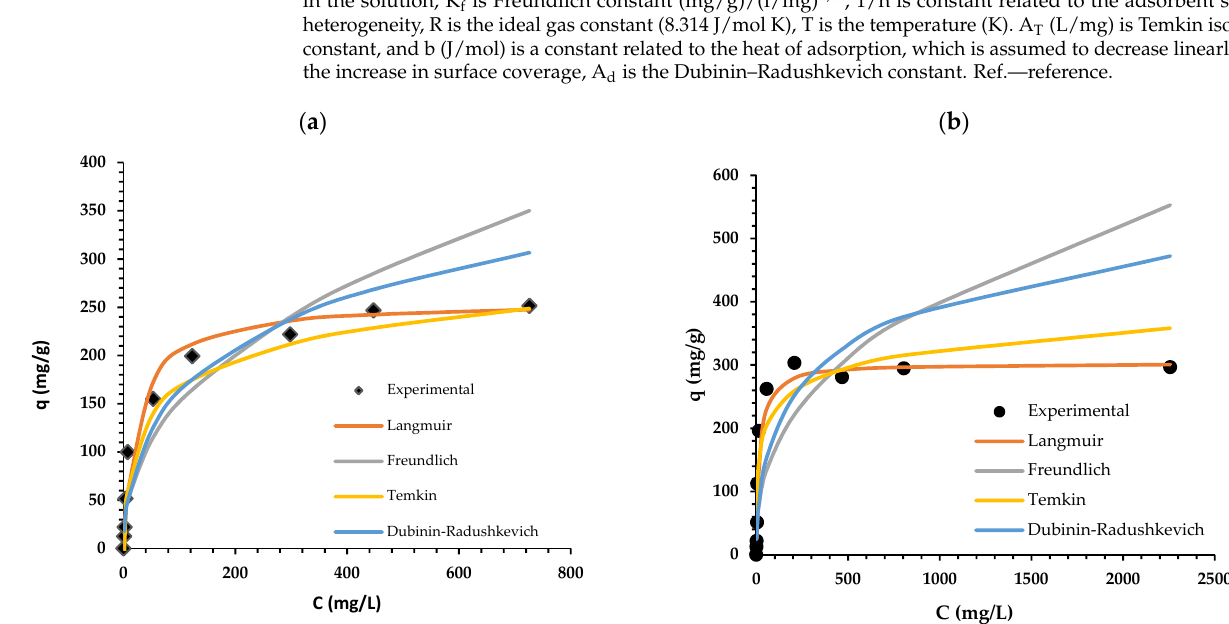
Figure 8. The efficiency of eucalypt stump lignin and kraft lignin in the removal of Cr(VI) at different initial concentrations. The FTIR spectra of the lignins before and after the adsorption experiments show noticeable differences (Figure 9a,b). According to the FTIR analysis of the initial lignins, both present a broad band in the hydroxyl (-OH) and methoxyl groups (-OCH 3 ) region (Figure 2); however, after adsorption, the eucalypt stump lignin spectrum shows a slightly broader band of lower intensity corresponding to the OH groups and almost a complete